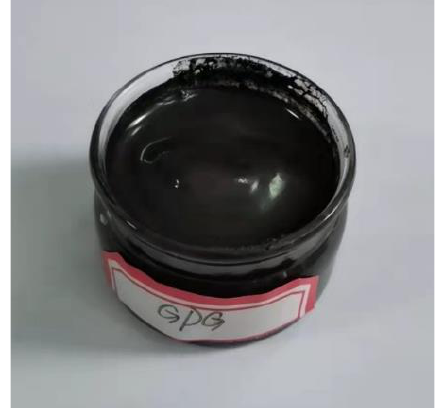
Figure 2. GPG Figure 2. GPG prepared.